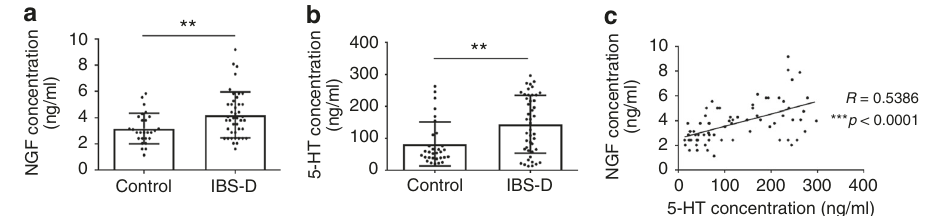
Fig. 7 NGF in normal intestinal homeostasis and irritable bowel syndrome. a , b ELISA assay reveals that there is a signi fi cant upregulation of both NGF ( a ) and 5-HT (serotonin) ( b ) in the sera of IBS patients with diarrhea (IBS-D) ( n = 31 for healthy controls; n = 45 for IBS-D patients) (** p < 0.01, two-tailed t test). c There is also a highly signi fi cant positive correlation between NGF and 5-HT in the sera derived from IBS-D patients and healthy controls (** p < 0.001, R = 0.5386, n = 70, Spearman ’ s